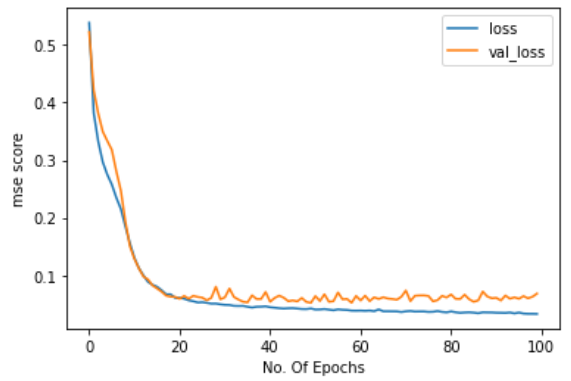
Figure 9. Train set and validation set loss